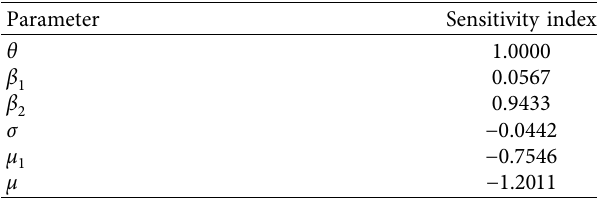
about different 0